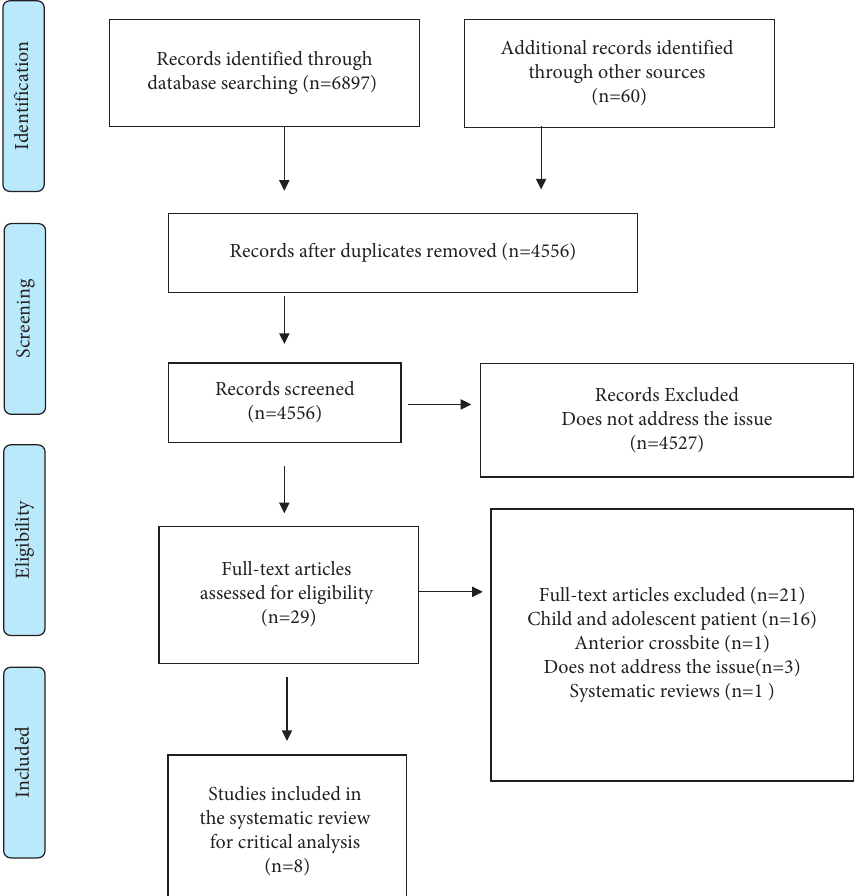
Figure 1: PRISMA flow diagram of study